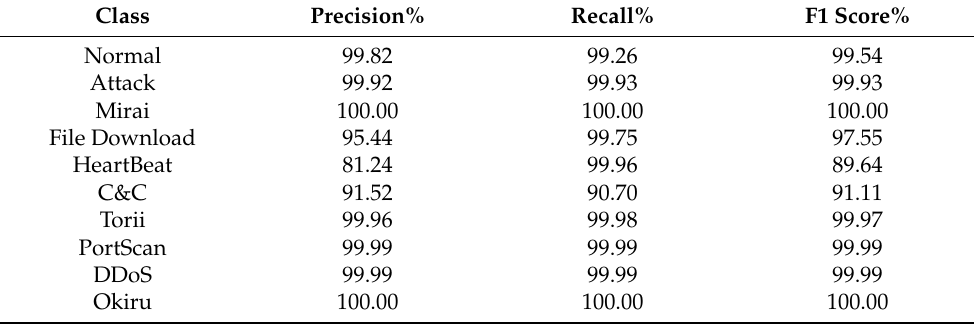
Table 9. IoT-23 multiclass classification.